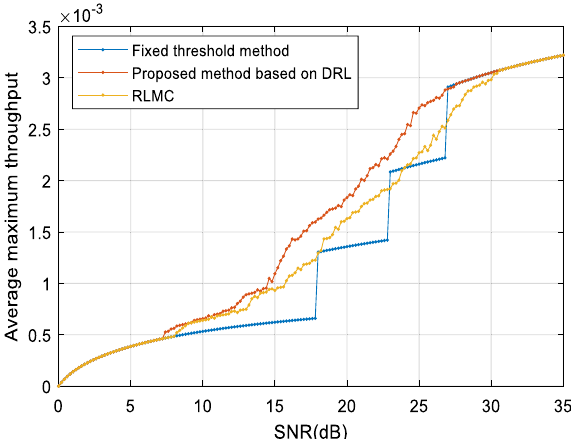
Fig. 14 Average maximum throughput in simulated environments